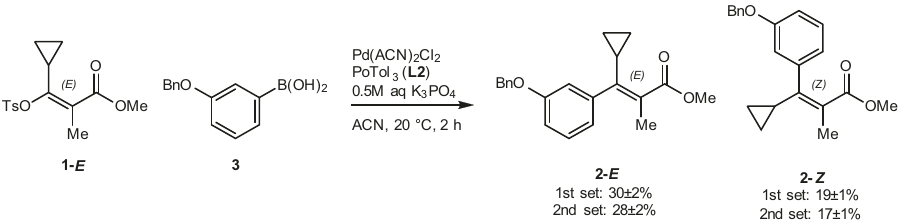
Fig. 3 Standard experimental conditions for reproducibility testing. Conditions: 10 µ mol 1- E , 1 µ mol 1,3,5-trimethoxybenzene, 15 µ mol (3-(benzyloxy)phenyl) boronic acid 3, 0.3 µ mol Pd(ACN) 2 Cl 2 , 0.4 µ mol L2, 30 µ mol K 3 PO 4 (0.5M aq) in ACN (0.05M), 2h at 20°C. Average yields for fi rst set of replicates: 2- E : 30 (±2)%; 2- Z : 19(±1)% and second set of replicates: 2- E : 28(±2)%; 2- Z : 17(±1)%. Tabulated results are provided in Supplementary Information Table